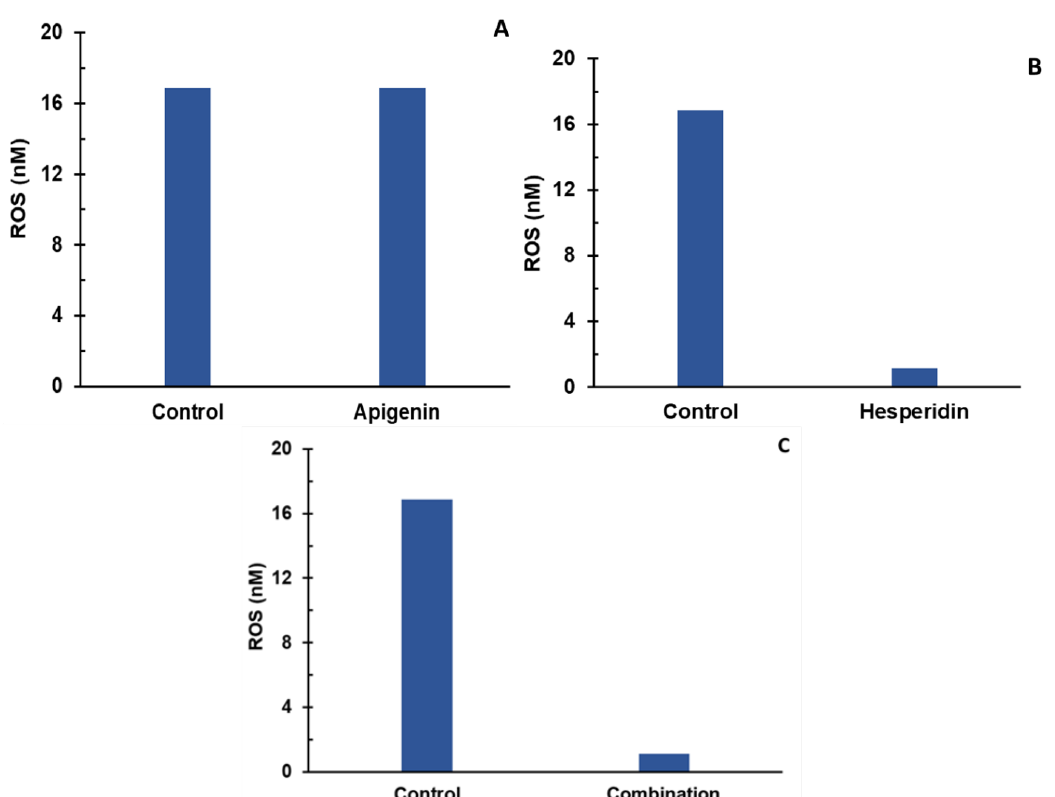
Figure 6. Individual ( A , B ) and combination effect ( C ) of apigenin and hesperidin on ROS production in chondrocytes over simulations periods of 2 days. Apigenin at 30 mg dose, ( A ) hesperidin at 1000 mg dose, ( B ) and their combination at 1030 mg dose ( C ) reduced the levels of ROS over a period of 2 days.